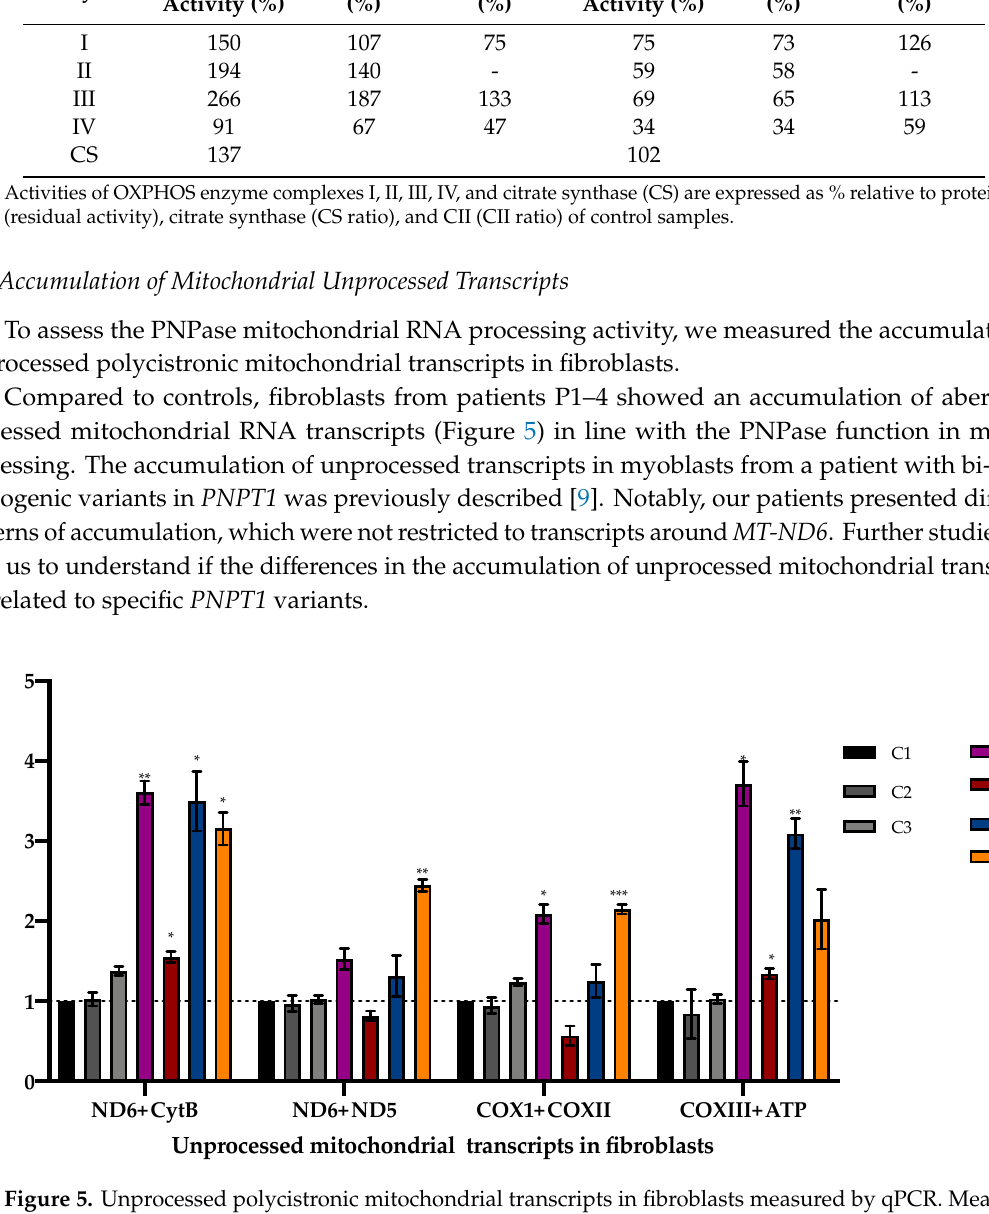
Figure 5. Unprocessed polycistronic mitochondrial transcripts in fibroblasts measured by qPCR. Mean and variation (SEM) between three independent experiments are shown (*** p < 0.001, ** p < 0.002, * p < 0.033).